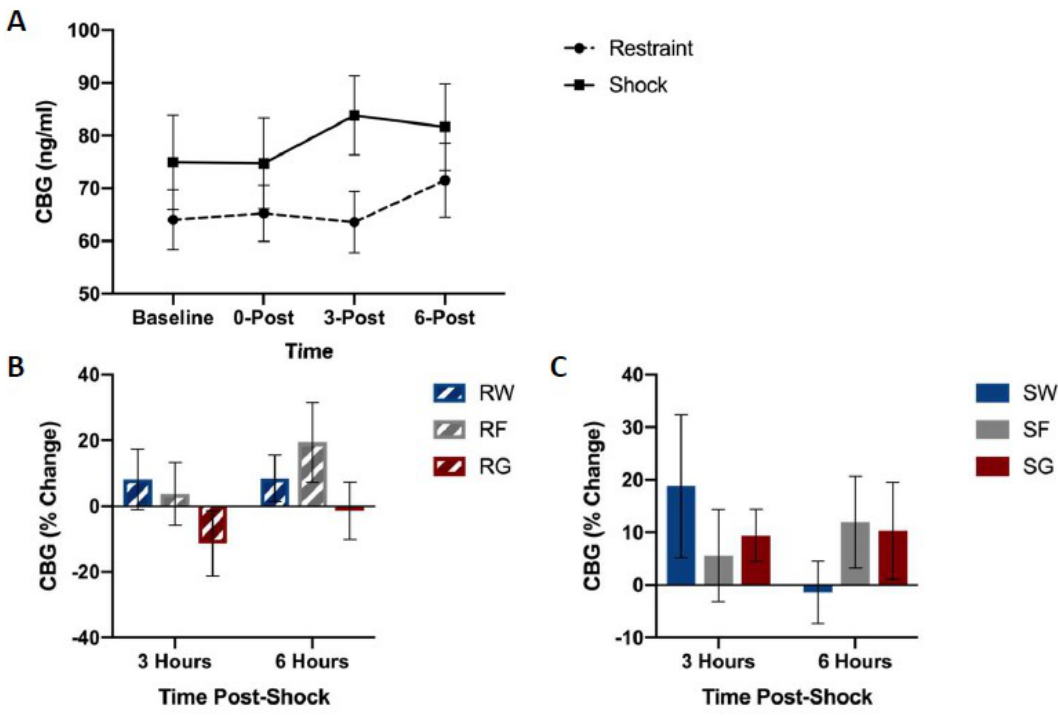
Figure 4. CBG concentrations between stress treatments (panel A ), and percent change from 0